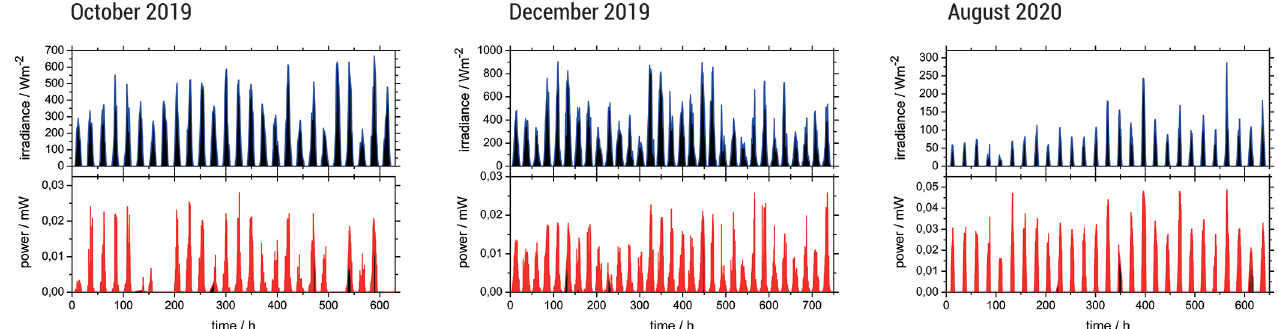
Fig. 5. Irradiance measured by a pyranometer and calculated power for the DSSC-panel during some speci fi c